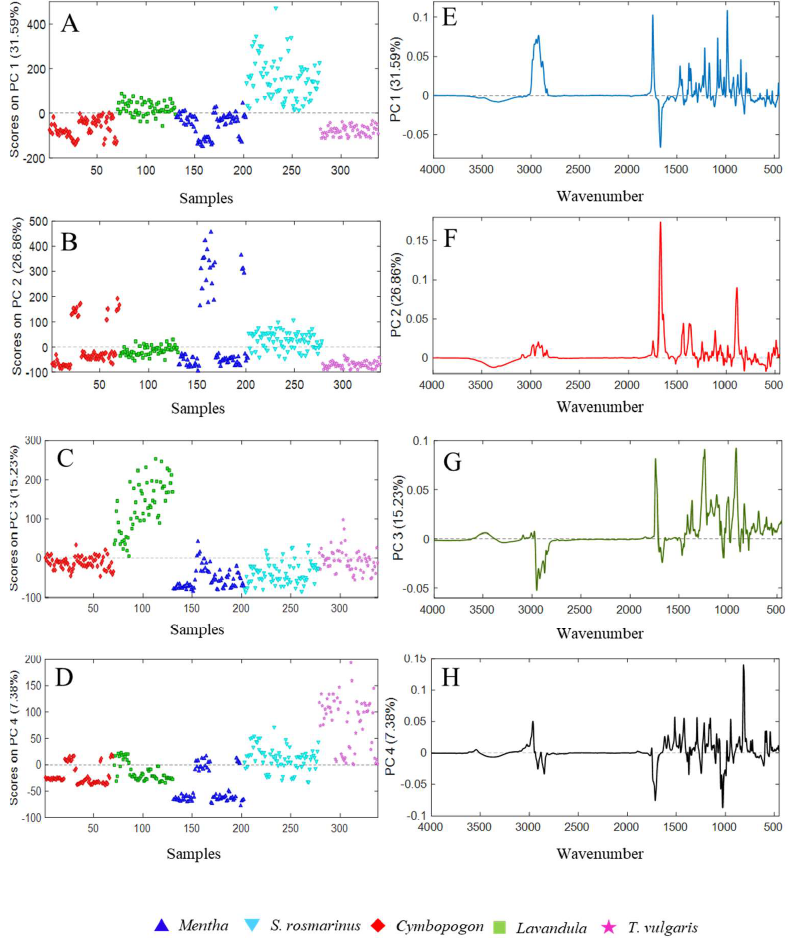
Figure 6. The scores on the extracted PCs (( A – D ) for PC1, PC2, PC3, and PC4 respectively) and their loading plots (( E – H ) of PC1, PC2, PC3, PC4, respectively), obtained from the principal component analysis (PCA) performed on the spectral data of the essential oils belonging to Mentha , Cymbopogon , and Lavandula genus , as well as Salvia rosmarinus and Thymus vulgaris